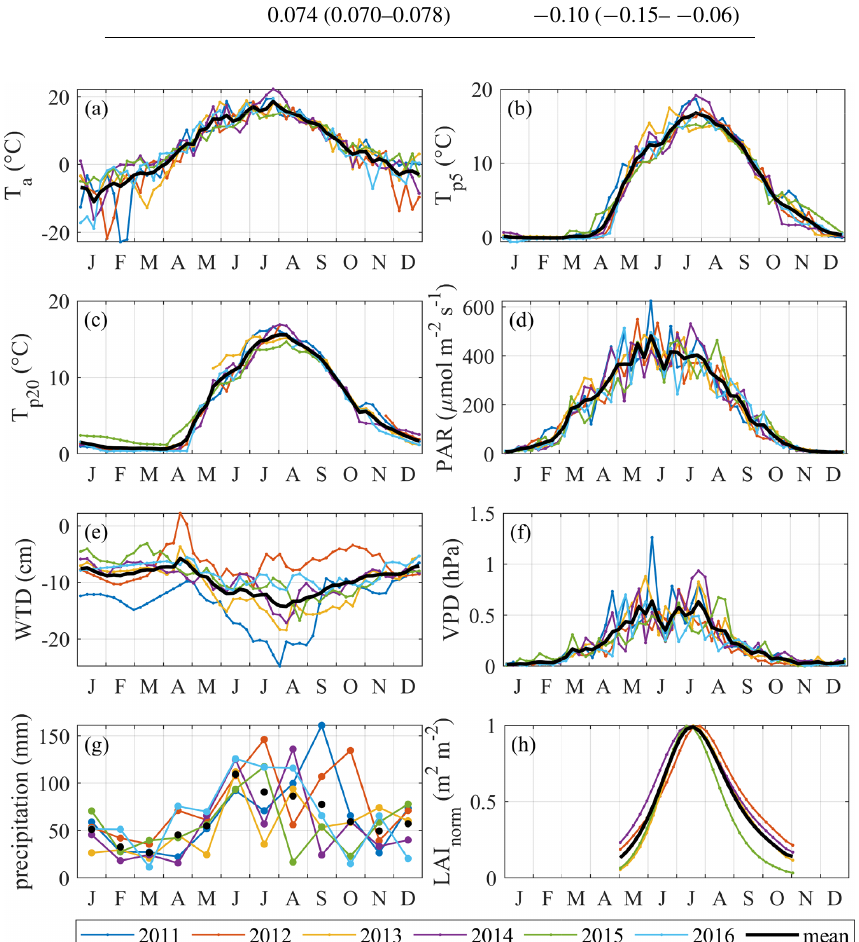
Figure 4. Time series of potential drivers of NEE, GPP, Re and F CH . LAI is normalized by the annual peak value. The color lines in ( a–d 4 and f ) represent weekly means, whereas in (e,h) they give daily average WTD and in (g) monthly precipitation sums. The black lines in (a–f) show the mean annual course of all years; the black markers in (g) are the monthly average precipitation of all years. and air temperature 3.5 ◦ C (Table 4). The summer is